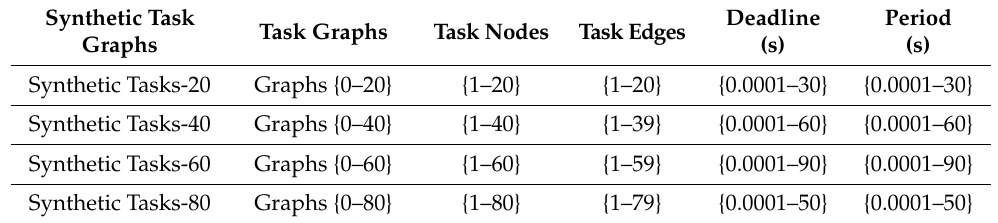
Table 5. Synthetic Task Graphs used for